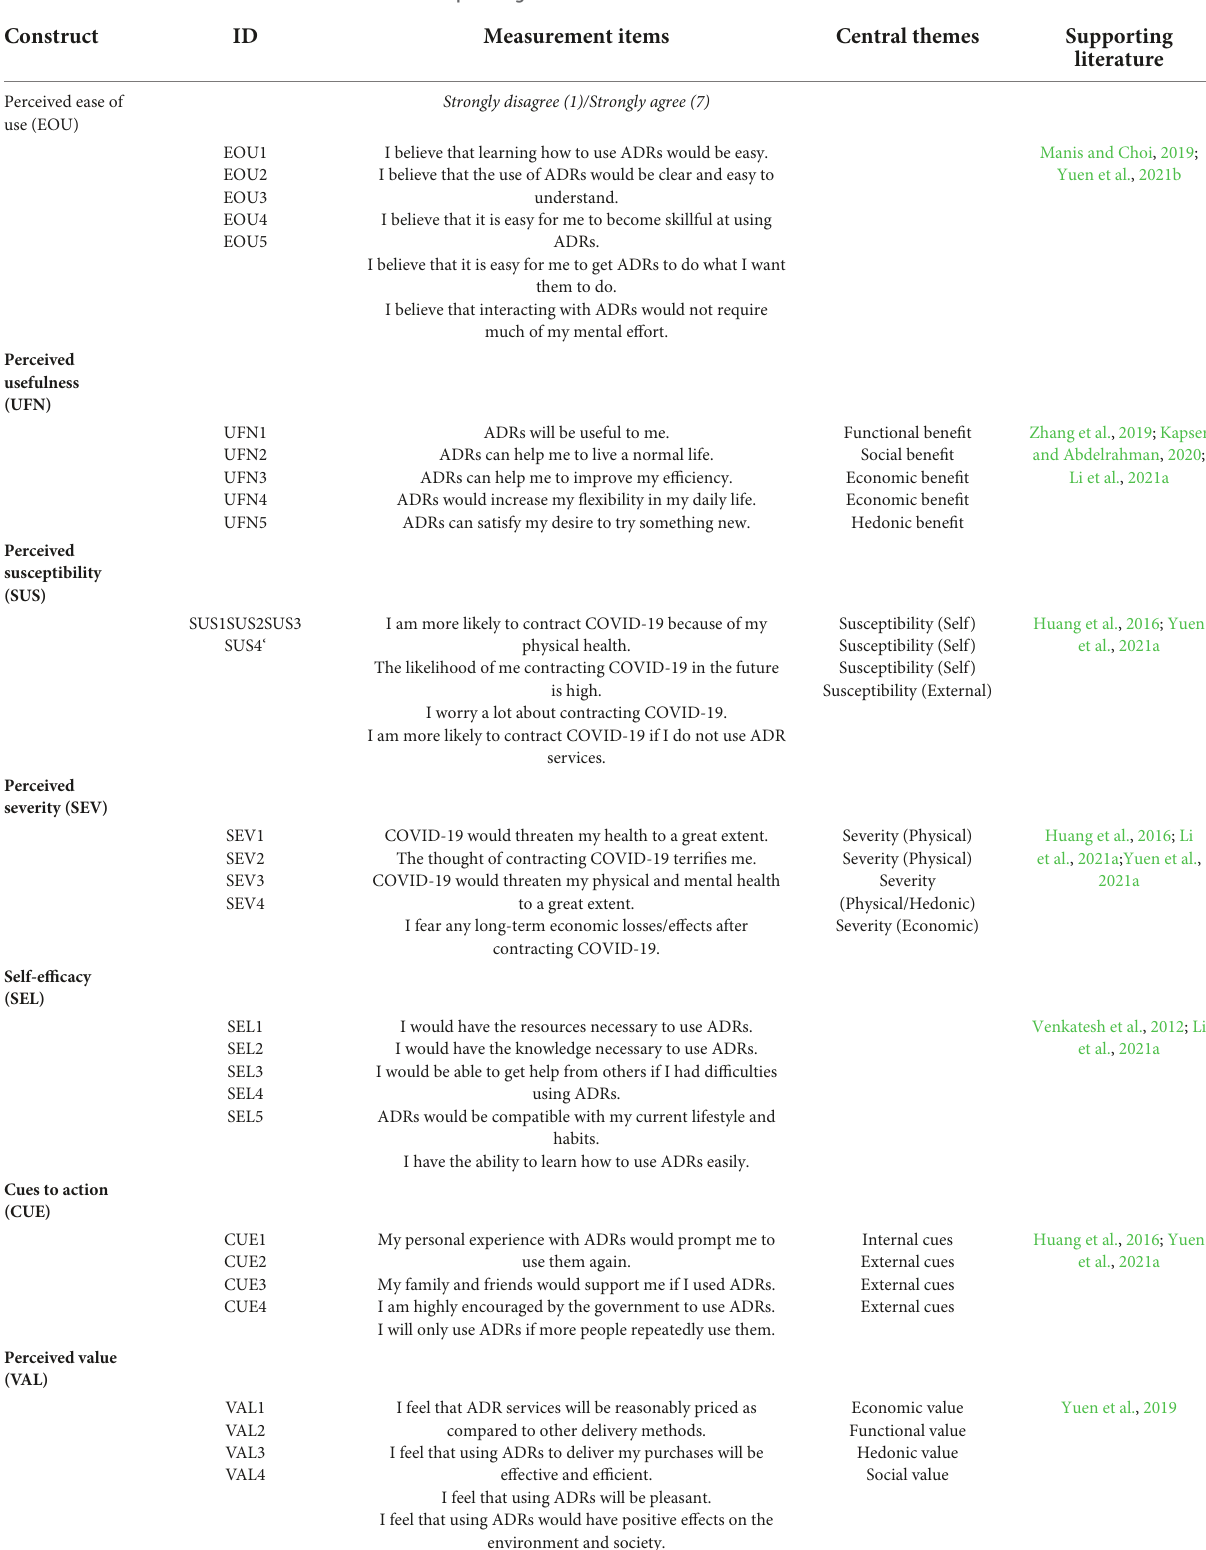
TABLE 2 Modified measurement items and their corresponding